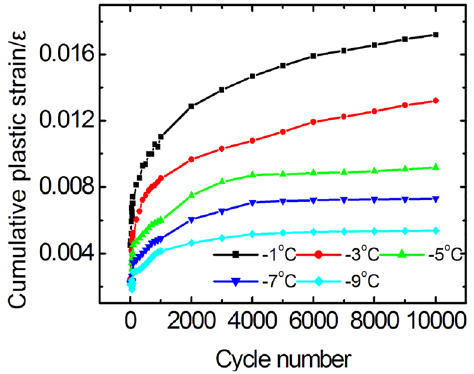
Fig. 13 Influence of the frequency on the cumulative plastic